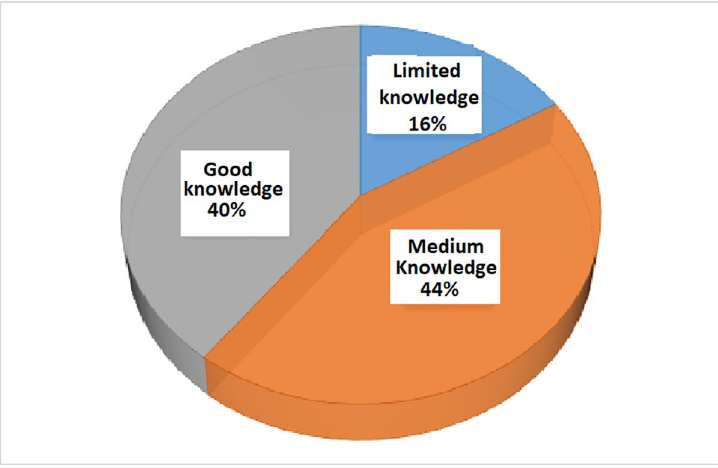
Fig 3. Knowledge distribution of participants (knowledge about COVID-19 and COVID-19 vaccination.